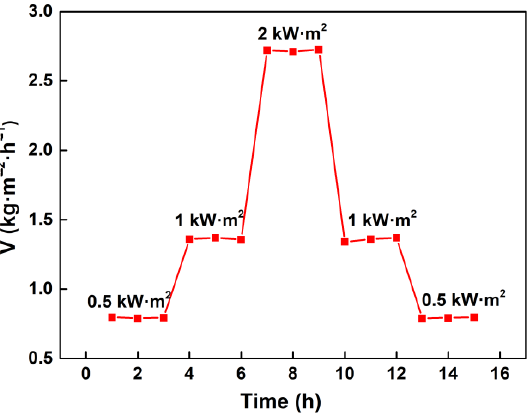
Figure 12. ( a ) Water mass loss of different samples; ( b ) Water evaporation rate and photothermal conversion efficiency.